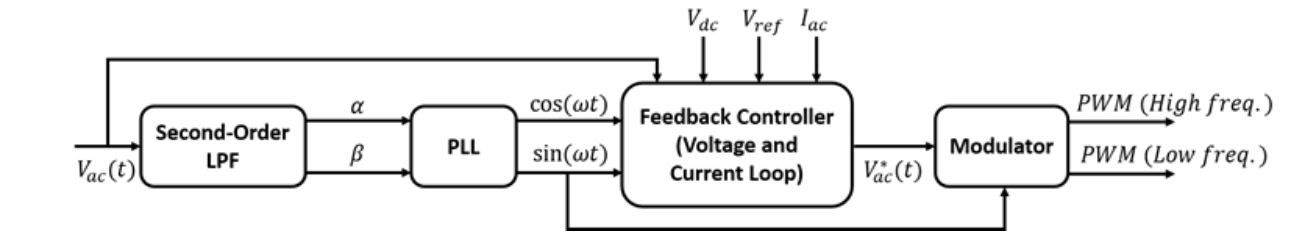
Figure 3. Functional blocks of the feedback control logic for the Totem Pole PFC.